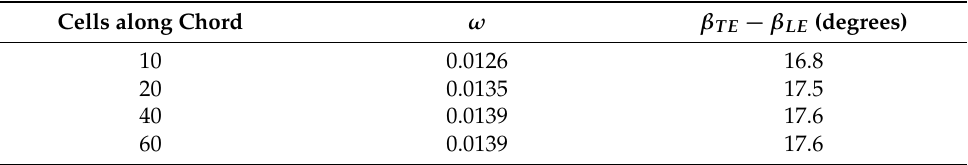
Table 4. Grid independence study for body force model in cascade 1 with M = 0.3. Zero incidence, σ = 1.0, Reynolds number based on chord 3.35 × 10 5